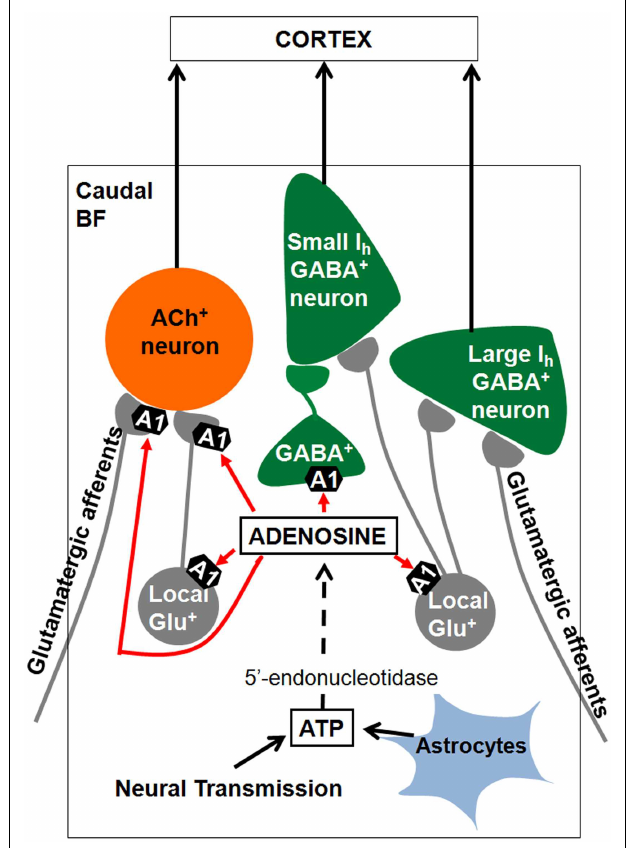
FIGURE 4 | Summary of results and model of how adenosine may promote sleep in the basal forebrain (BF) . BF cholinergic and GABAergic/PV neurons project to the cortex and promote cortical activation through their effects on cortical pyramidal neurons and GABAergic interneurons. During prolonged wakefulness extracellular adenosine levels rise due to transport of adenosine by plasma membrane transporters (not shown) or due to degradation of ATP released from glia or as a co-transmitter. Adenosine inhibits cortically projecting BF cholinergic and GABAergic neurons by inhibiting their local glutamatergic inputs through activation of A1 receptors, thus promoting sleep. Adenosine also inhibits the glutamate release from the axon terminals to cholinergic neurons, which could be from either local or distant glutamatergic neurons. Some local GABAergic neurons sending projections to small I h GABAergic neurons are also sensitive to adenosine. ACh + , cholinergic ATP, adenosine